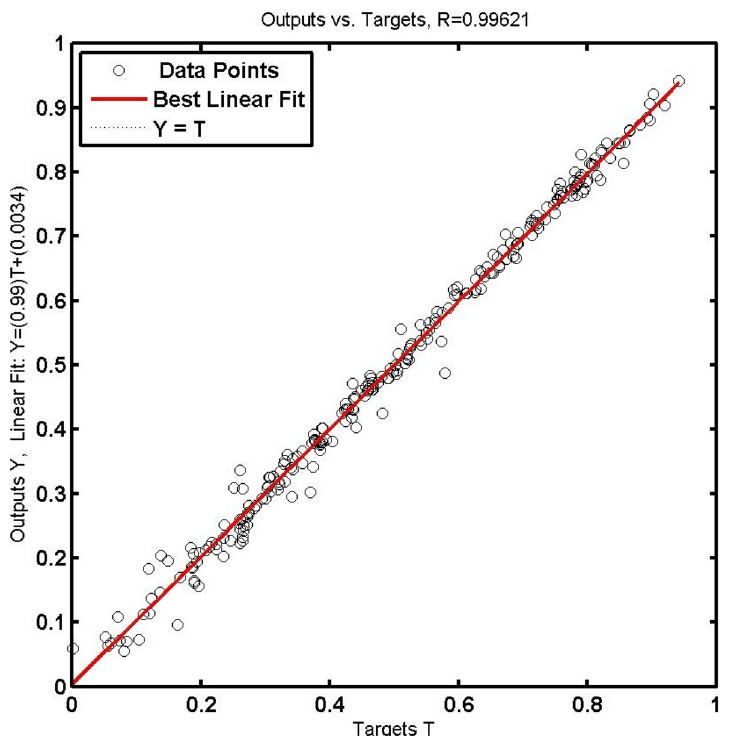
Fig. 15 Predicted (Outputs) minimum transient head just downstream the pump versus actual values (Targets) for the 2nd network